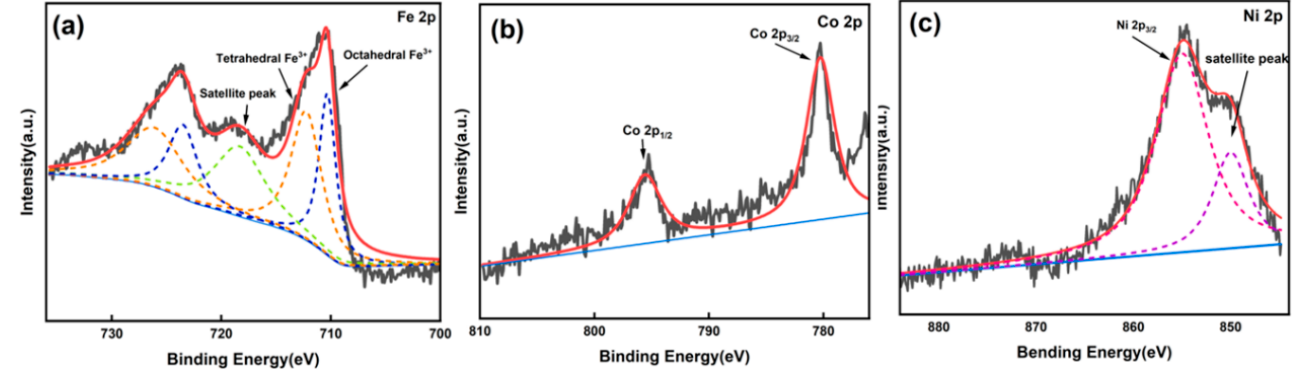
Figure 5. ( a ) Fe 2p, ( b ) Co 2p, and ( c ) Ni 2p spectra of the 10CuO-3MOx/ α -MnO 2 -400 (MOx = Fe 2 O 3 , Co 3 O 4 , NiO) catalysts. Table 3. XPS electronic binding energies of surface elements of the 10CuO-3MOx/ α -MnO 2 -400 (MOx = Fe 2 O 3 , Co 3 O 4 , NiO) catalysts.